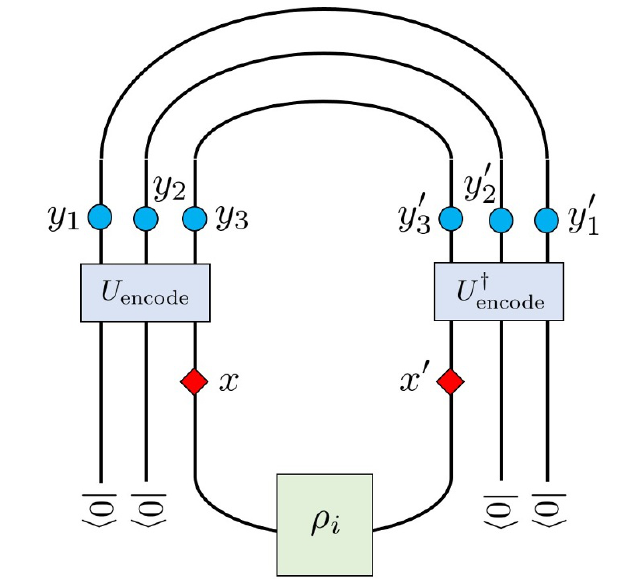
Figure 15 . The spacetime state for the three qutrit